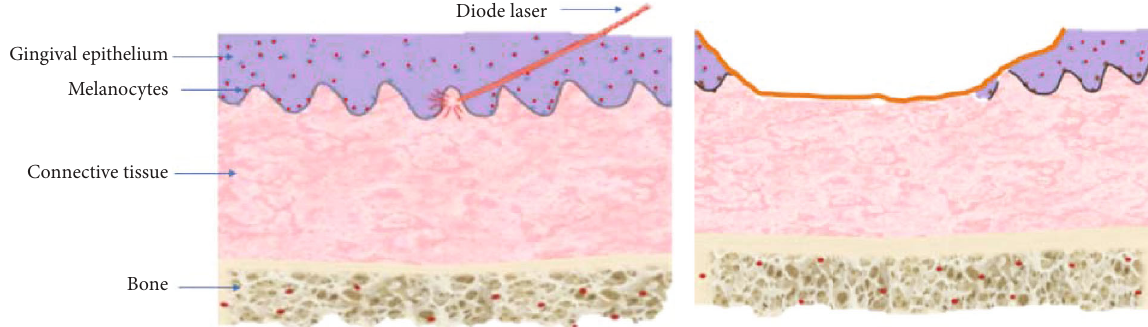
Figure 5: Gingival stripping of the basal layer of the